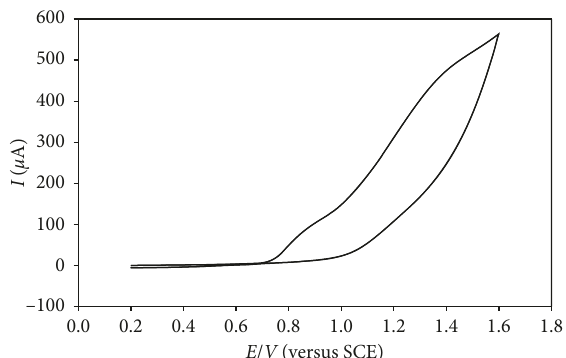
E / V (versus 3 M adenine +1.0 10 × −